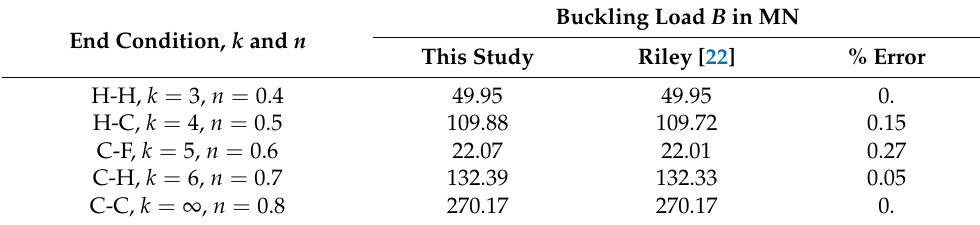
Table 1. Comparisons of buckling load B * for λ = 0. End Condition, k and n